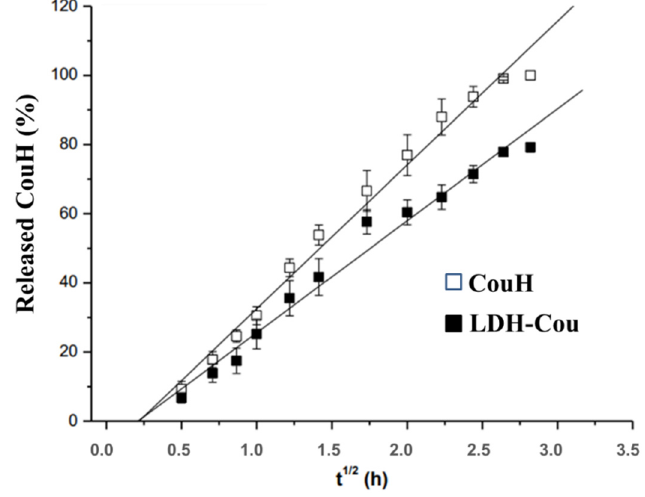
Figure 3. Higuchi model applied to the release kinetic curves of CouH and the intercalated species (LDH-Cou).